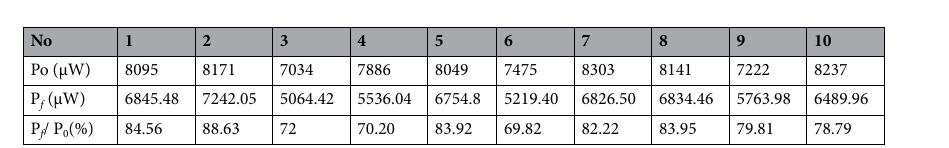
Figure 8. Experiment of asphetic lens coupling lights from laser diode to single mode fiber ( a ) Photo of experimental setup for measuring the optical coupling efficiency, ( b ) Schematic of experimental setup and measurement principle.